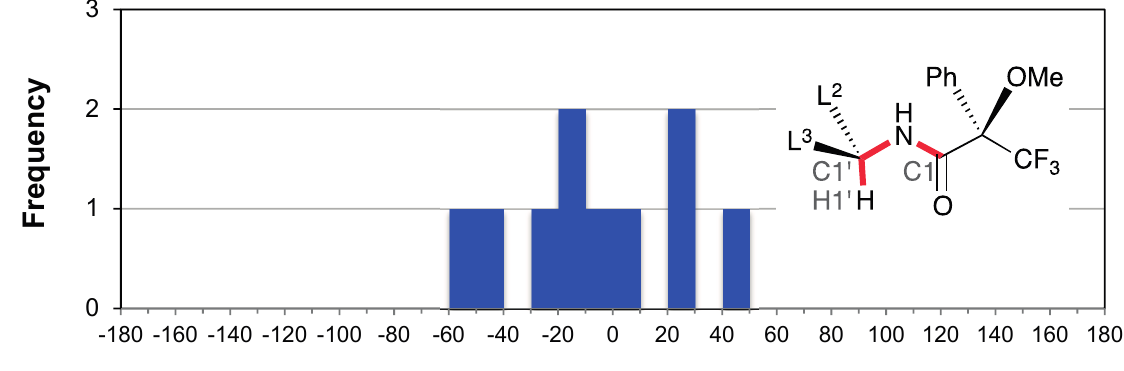
Figure 8. Histogram for dihedral angles H1 ′ –C1 ′ –N–C1 of the MTPA amides prepared from primary amines possessing a secondary alkyl